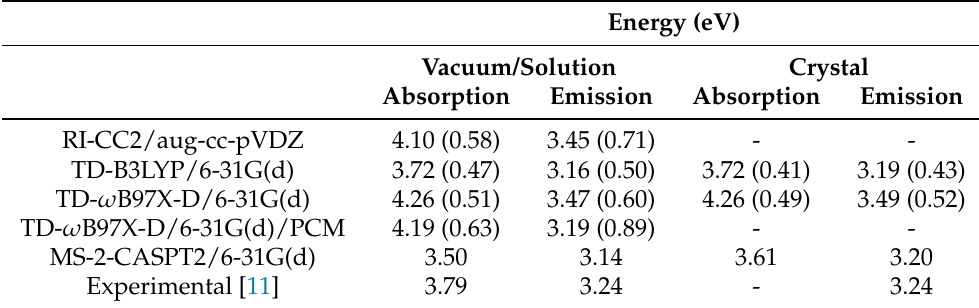
Table 1. Vertical absorption and emission energies and oscillator strengths (in parentheses) of the S 1 state of TPF in the vacuum, solution of THF, and crystal environment.